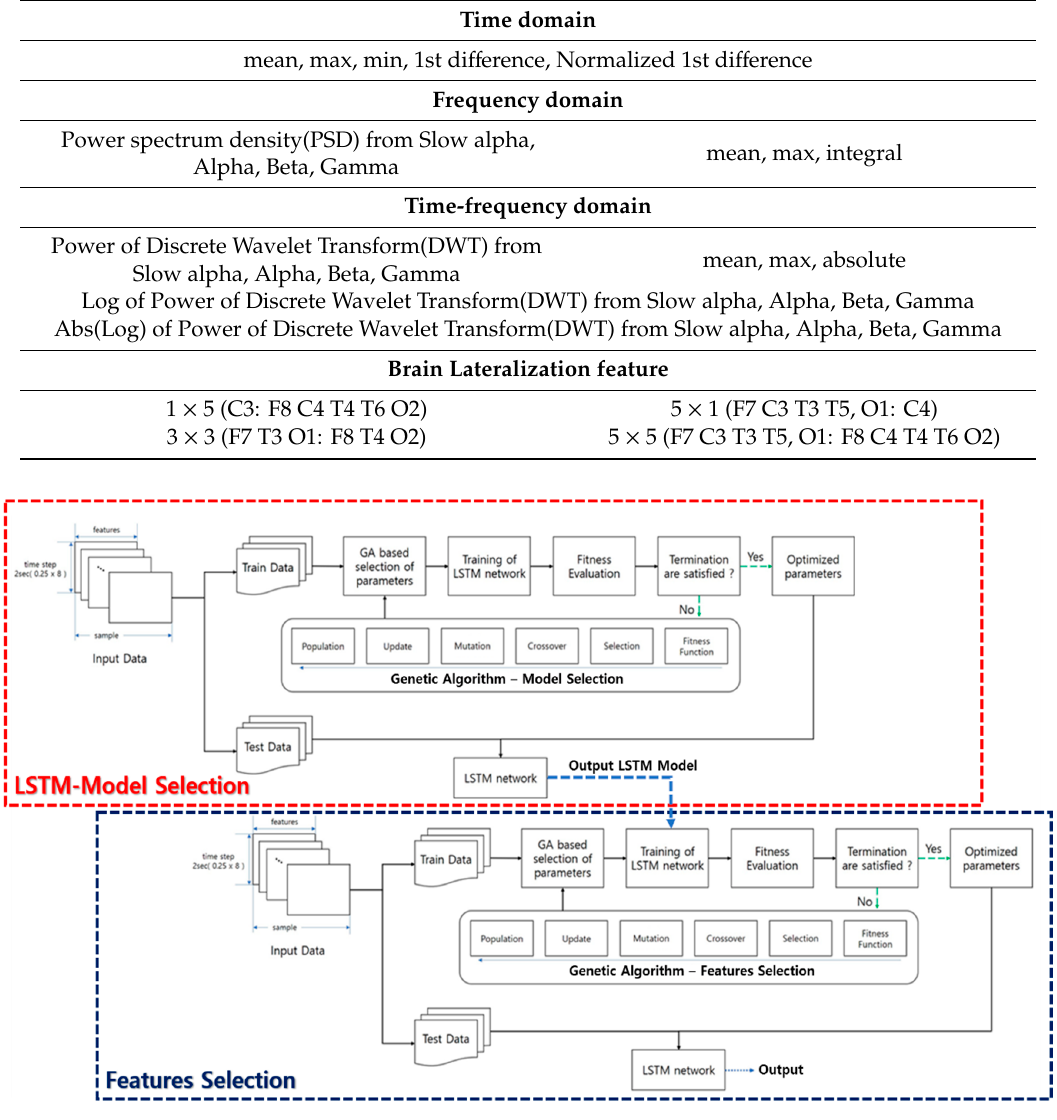
Table 5. EEG feature list for genetic algorithm—long short-term memory (GA-LSTM).